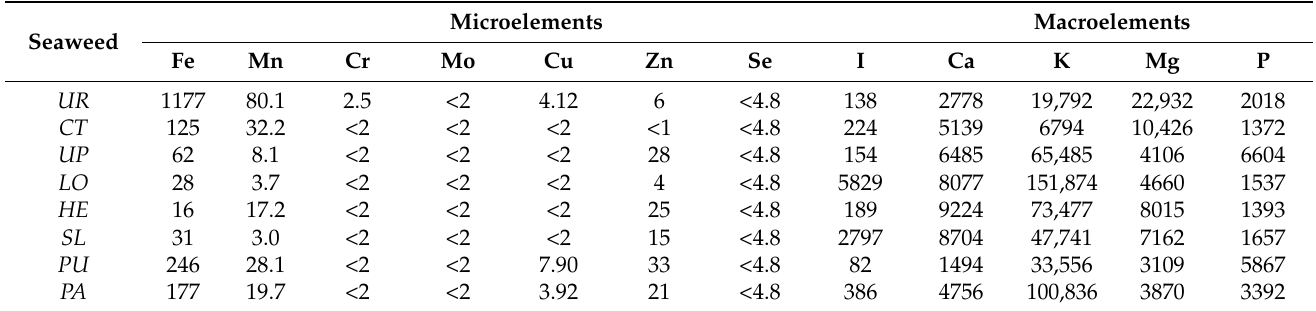
Table 3. Composition of elements in the studied seaweeds (mg/kg DM).